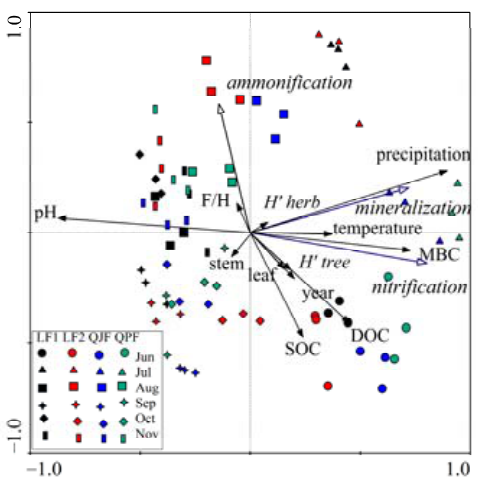
Figure 7. Redundancy analysis using net N transformations data as response variables and climate, plant and soil properties as explanatory variables.